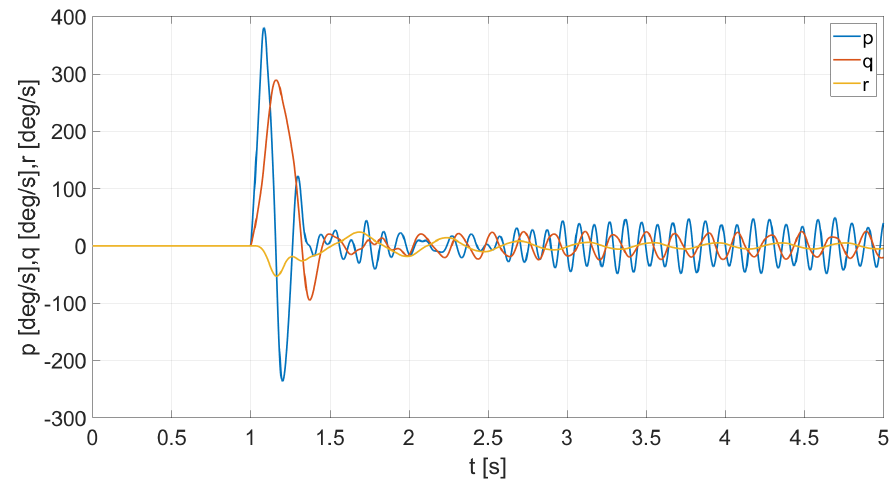
Figure 4. UAV angular speed response—PID control mode.